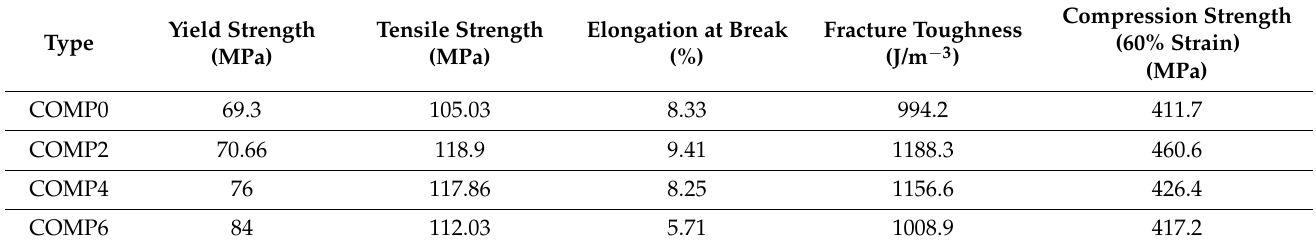
Table 2. Result summary of mechanical experiments.